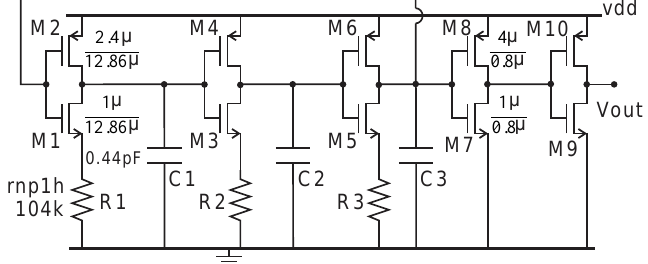
Figure 19. 500kHz RC oscillator.